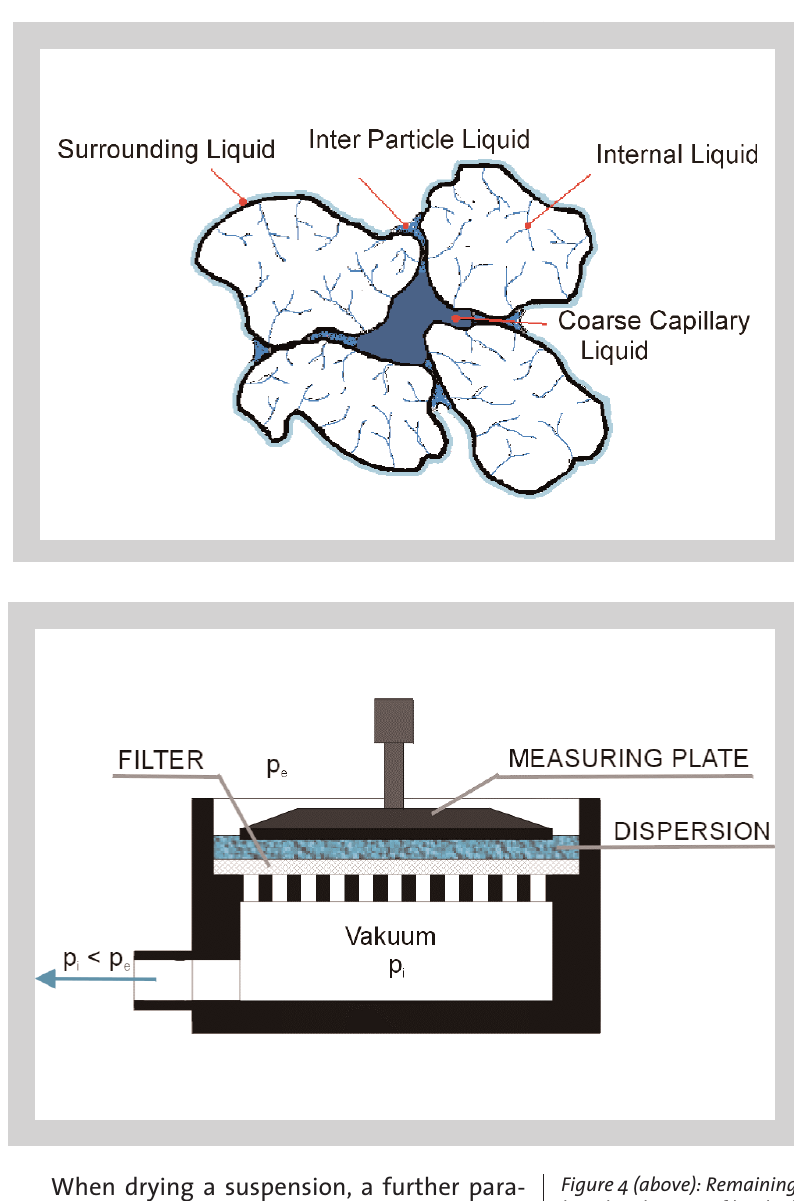
Figure 4 (above): Remaining liquid in the moist filter bed. Figure 5 (below): The Immobilization Cell